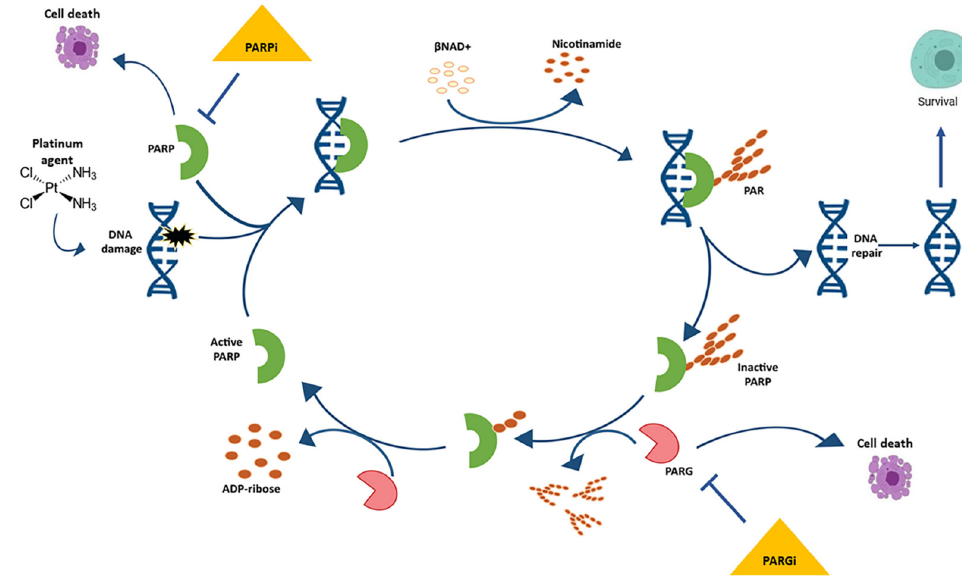
Figure 1. The cycle of poly ADP-ribose (PAR) metabolism “PARylation”. Poly ADP-ribose polymerase (PARP) binds the damaged DNA, becomes active,